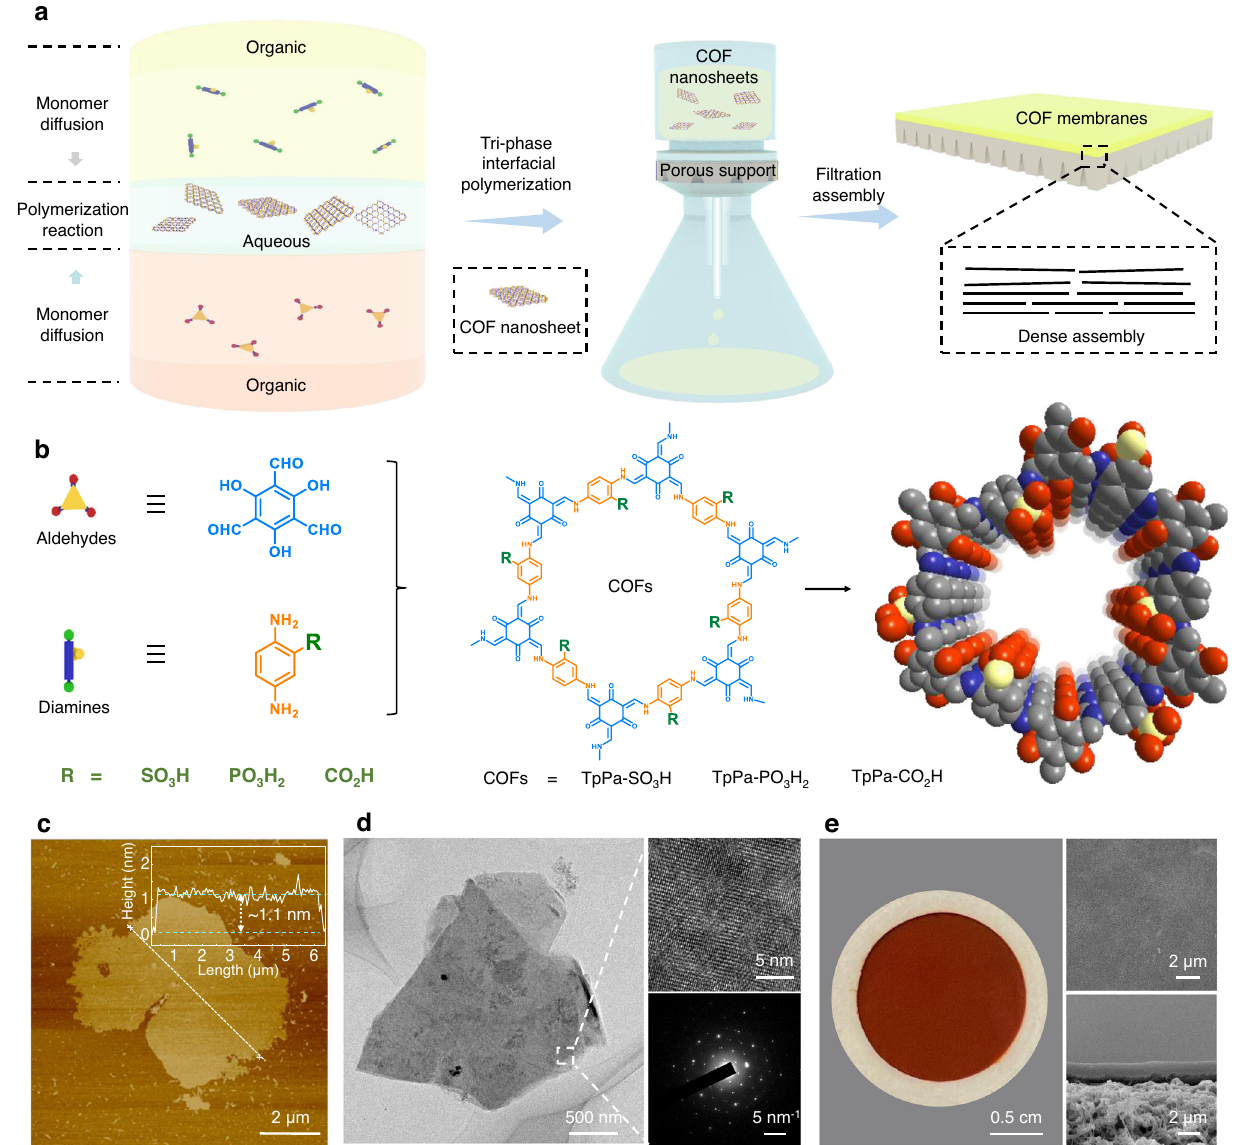
Fig. 2 | Fabrication and morphology characterization of COF nanosheets and membranes. a Schematic illustration of the tri-phase interfacial polymerization method to synthesize COF nanosheets and fi ltration method to fabricate COF membranes. For tri-phase interfacial polymerization, the top organic phase con- tained diamine monomers with varied acid groups; the middle aqueous phase was comprised by pure water, acid or basic solution; and the bottom organic phase contained aldehyde monomers. After a period of reaction, COF nanosheets were formed in the aqueous phase. COF nanosheets were subsequently fi ltrated onto porous supports to fabricate COF membranes. b Chemical formula of aldehydes